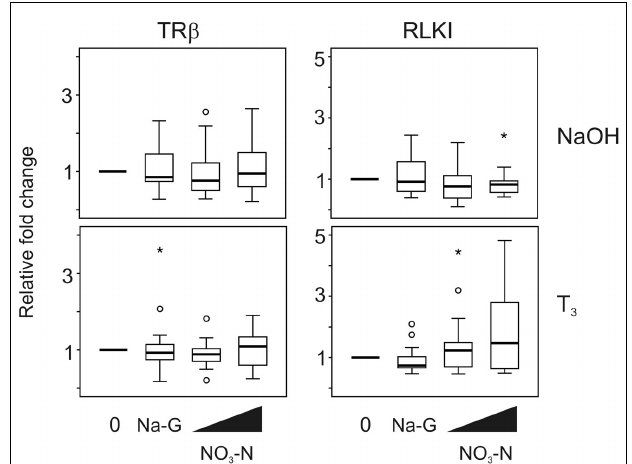
FIGURE 3 | QPCR analysis of thyroid hormone receptor β ( TR β ) and Rana larval keratin I ( RLKI ) transcript levels in the C-fin assay after exposure to nitrate in the absence or presence of 10nMT 3 . Tail fin biopsies were exposed to vehicle control (water; 0) and the indicated test chemicals for 48h in the presence of 400nM NaOH or 10nMT 3 in 400nM NaOH solvent.Test chemical concentrations were 50mg/L sodium control (in the form of sodium gluconate, Na-G), 5 and 50mg/L NO 3 –N (in the form of NaNO 3 ).The results are expressed as fold change relative to the vehicle control (NaOH; upper panels) or to the vehicle + T 3 -induced levels (lower panels) and represent QPCR data from n = 14–16 animals. Increasing concentrations of test chemicals are represented by bevels. See Figure 1 legend for more